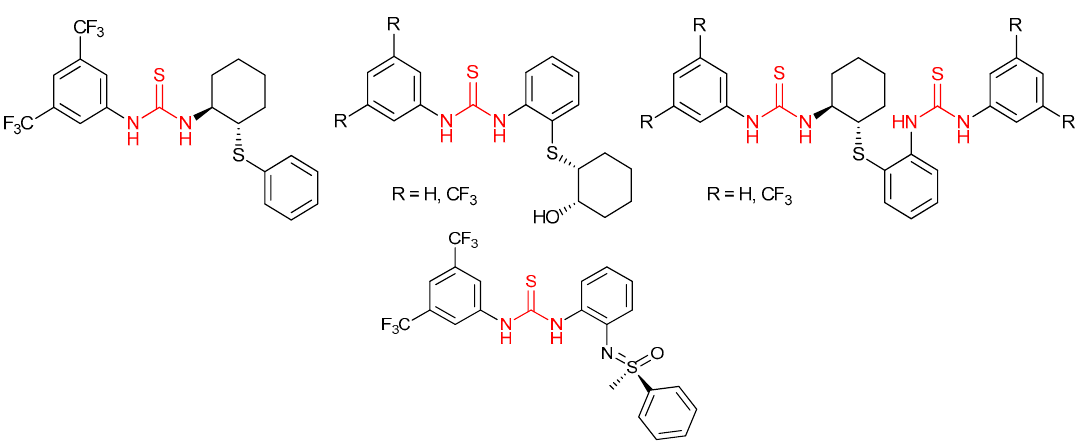
Figure 33. Chiral thioureas substituted with thioether groups [348] and sulfoximine [41].